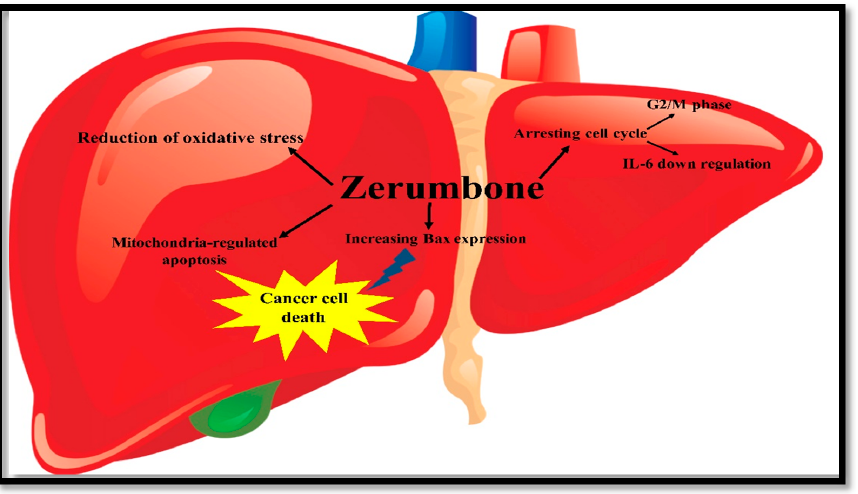
Figure 7. Different approaches of ZER can effect on liver cancer cells.